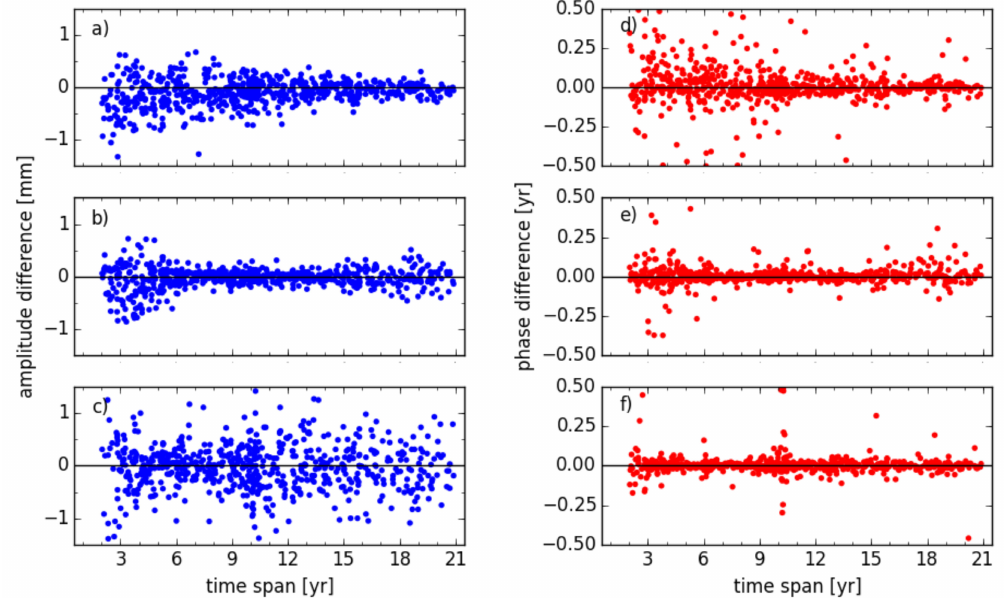
Figure 3. Difference of annual signal between simulated and those derived from the solution sim_unit_none for amplitudes ( left panel ) and phase ( right panel ), with ( a , d ) for the east, ( b , e ) for the north, and ( c , f ) for the vertical